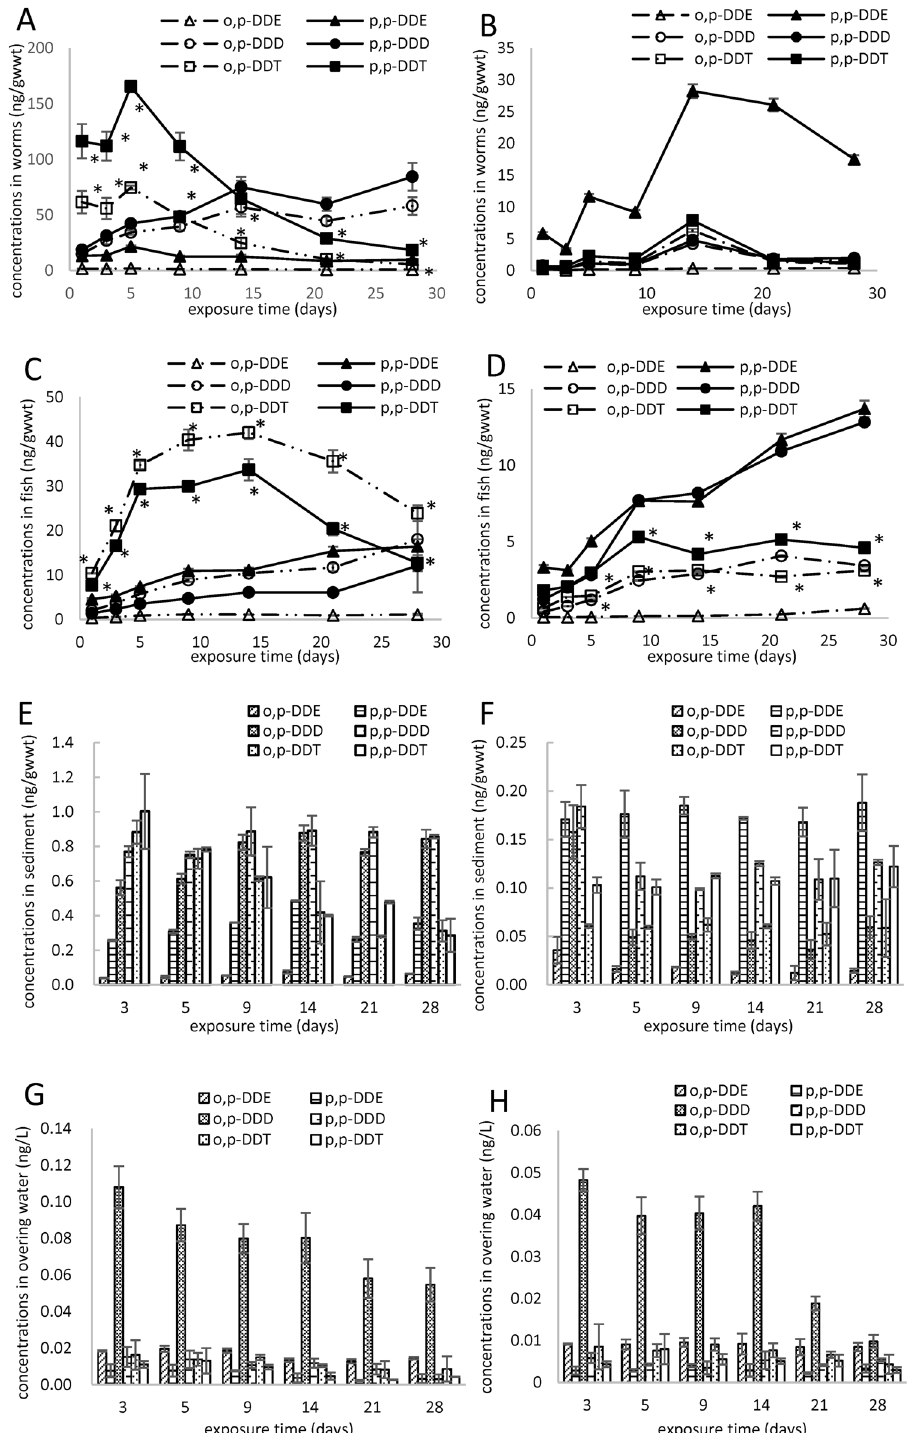
Figure 1. The bioaccumulation of DDTs in T. tubifex ( A ,a), carp ( B ,b), sediment ( C ,c) and overlying water ( D ,d) in the treatment group and control group. * Indicates significant difference between p,p’-DDT and o,p’- DDT ( p < 0.05, S-N-K